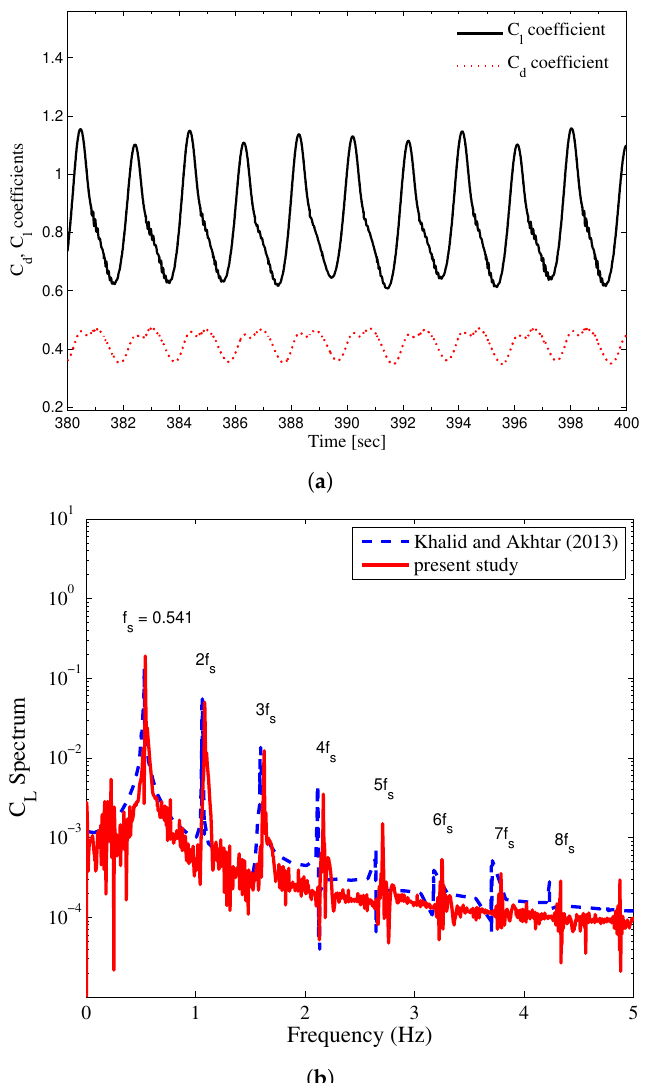
Figure 5. ( a ) Time histories of lift and drag coefficients. ( b ) Amplitude spectrum of lift